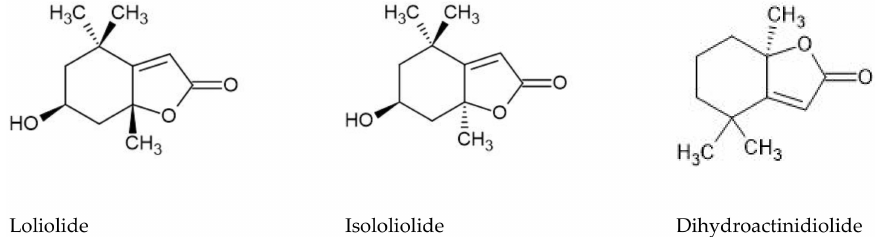
Figure 2. Chemical structures of loliolide, isololiolide and